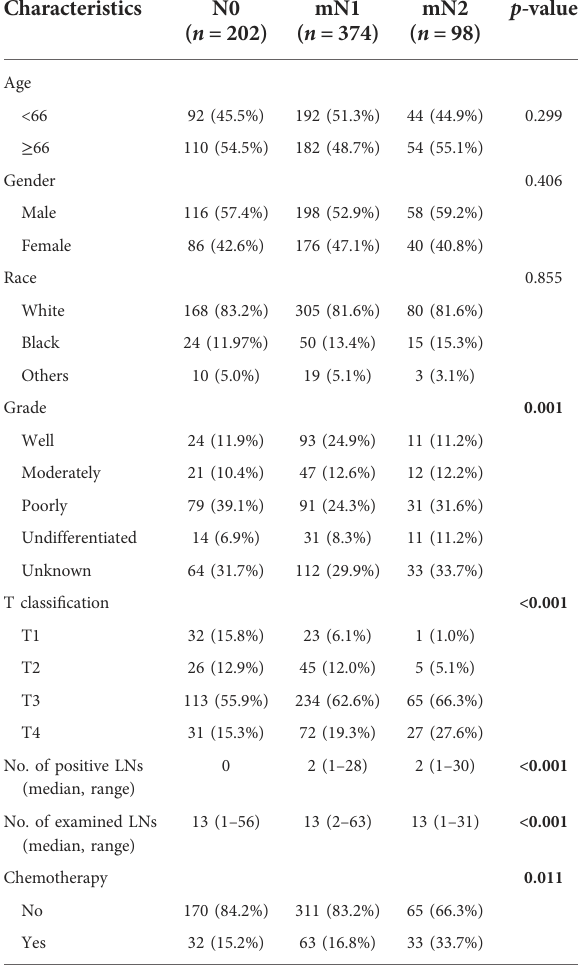
TABLE 2 Patient characteristics for proposed mN0/mN1/mN2 stage for colon NETs patients in the SEER cohort. Characteristics